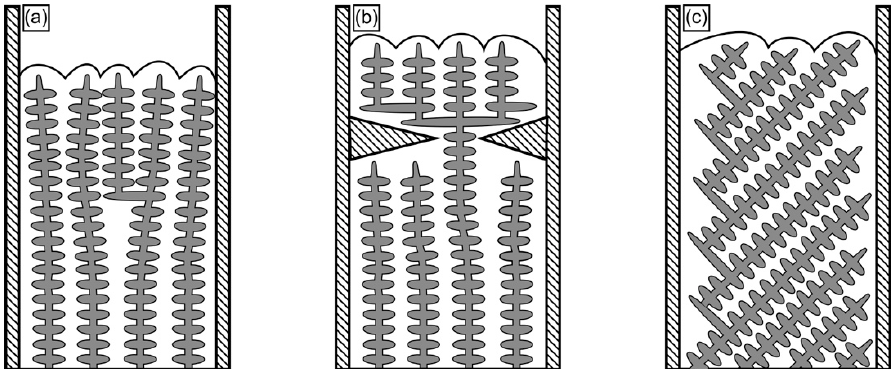
Figure 15. Potential scenarios which result in different levels of crystal mosaicity. ( a ) Formation of a high degree of mosaicity during directional solidification. ( b ) Formation of a low mosaicity microstructure after overcoming a growth obstacle. ( c ) Continuous branching followed by continuous re-emerging.